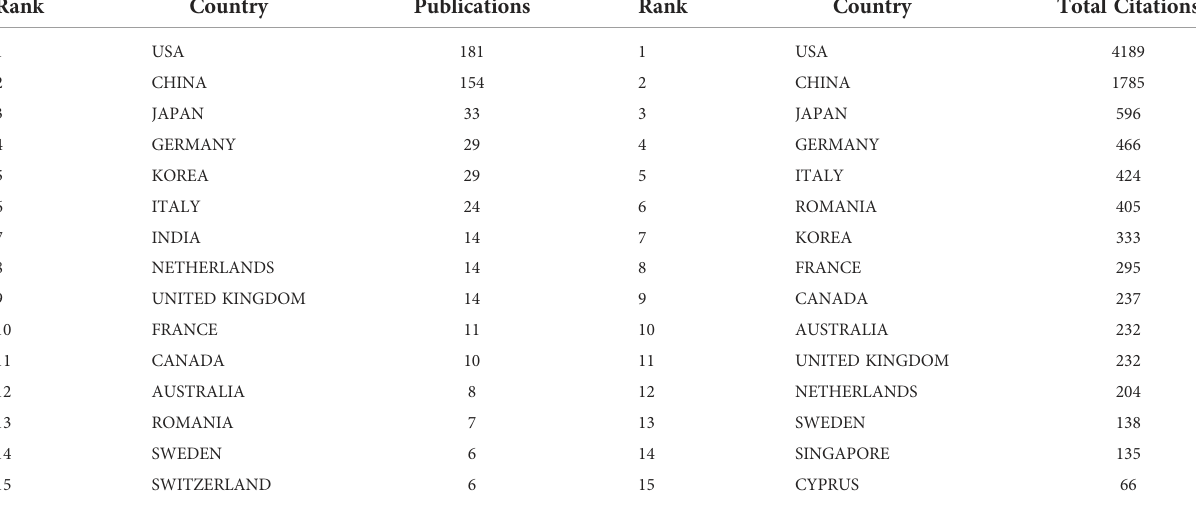
TABLE 1 Top 15 countries/regions with highest publications and total citations on AI in pancreatic cancer. Rank